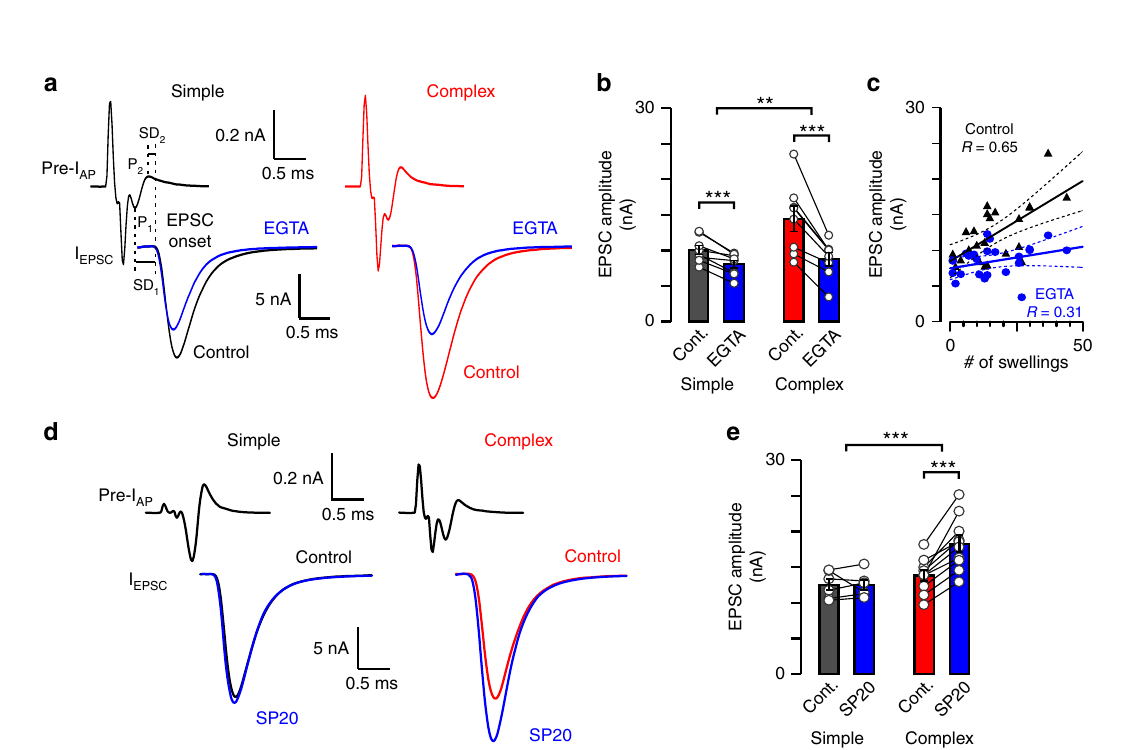
Fig. 5 Synaptic strength is more sensitivity to EGTA and downregulated by septin 5 in complex calyces. a Presynaptic compound action potential currents (pre-I AP ) and EPSCs (I EPSC ; axonal stimulation) were tested in control (black, simple calyx; red, complex calyx) and after EGTA injection (blue, 10 mM, 3 – 5 min loading). SD 1 (interval between peak 1 of pre-I AP and EPSC onset) and SD 2 (interval between peak 2 of pre-I AP and EPSC onset; dashed lines) are synaptic delays. b Bar graphs show EGTA effect on EPSC amplitudes (simple, control, 10.05 ± 0.64 nA, EGTA, 8.06 ± 0.55 nA, n = 8/7, t = 5.762, p = 0.0007, df = 7, paired t -test [p.t.t.]; complex, control, 14.44 ± 1.76 nA, EGTA, 8.77 ± 0.93 nA, n = 8/8, t = 5.558, p = 0.0009, df = 7, p.t.t.). The difference 3.552, p = 0.0032, df = 14, unpaired t -test [u.t.t.]). c EPSC amplitudes for all EGTA injected synapses were plotted against swelling number (black triangles, control; blue dots, EGTA) and fi tted linearly (mean ± 95% con fi dence interval). d , Pre-I AP and I EPSC were tested in control (black, simple calyx; red, complex calyx) and after septin 5 antibody injection (blue, SP20, 1:1000, 3 – 5 min loading). e Bar graphs show SP20 effect on EPSC amplitudes 10 – 15 min after presynaptic pipette removal (simple, control, 12.53 ± 0.77 nA, SP20, 12.46 ± 0.70 nA, n = 6/4, t = 0.1137, p = 0.914, df = 5, p.t.t.; complex, control,